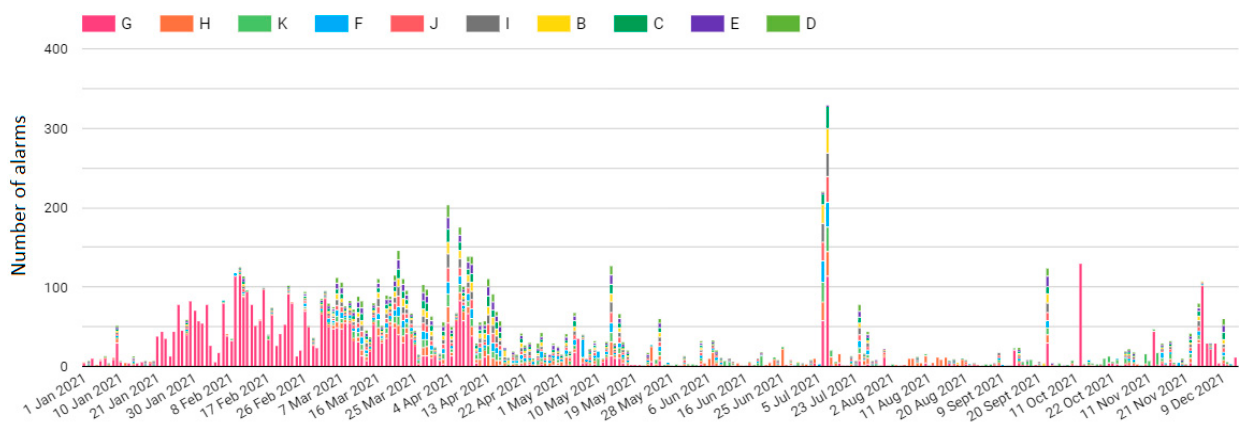
Figure 22. Statistical analysis of the inverter failure alarms for the test PV plant over the course of the evaluation period.